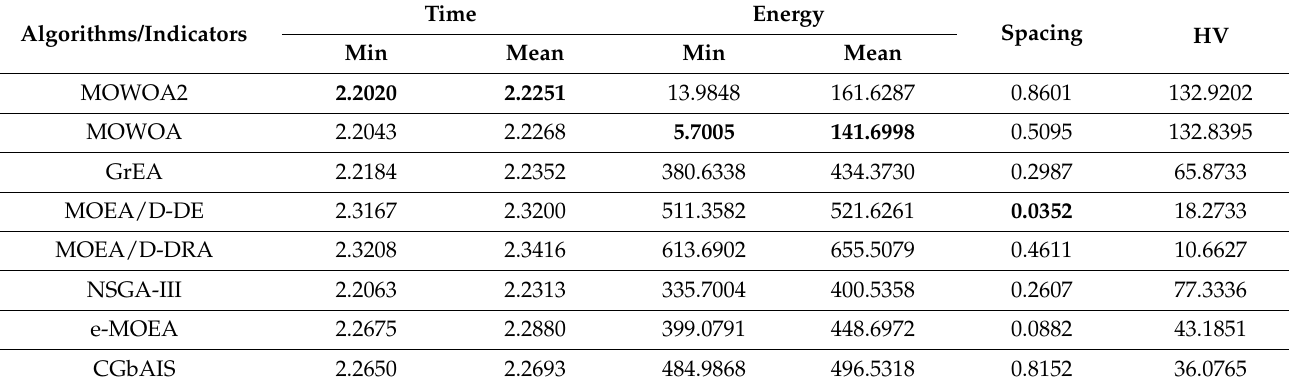
Table 5. The values of indicators using different algorithms when the user number is 60. The bold number is the best value in this